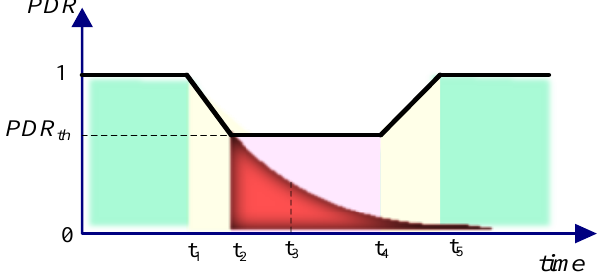
Figure 4. Resiliency curve.